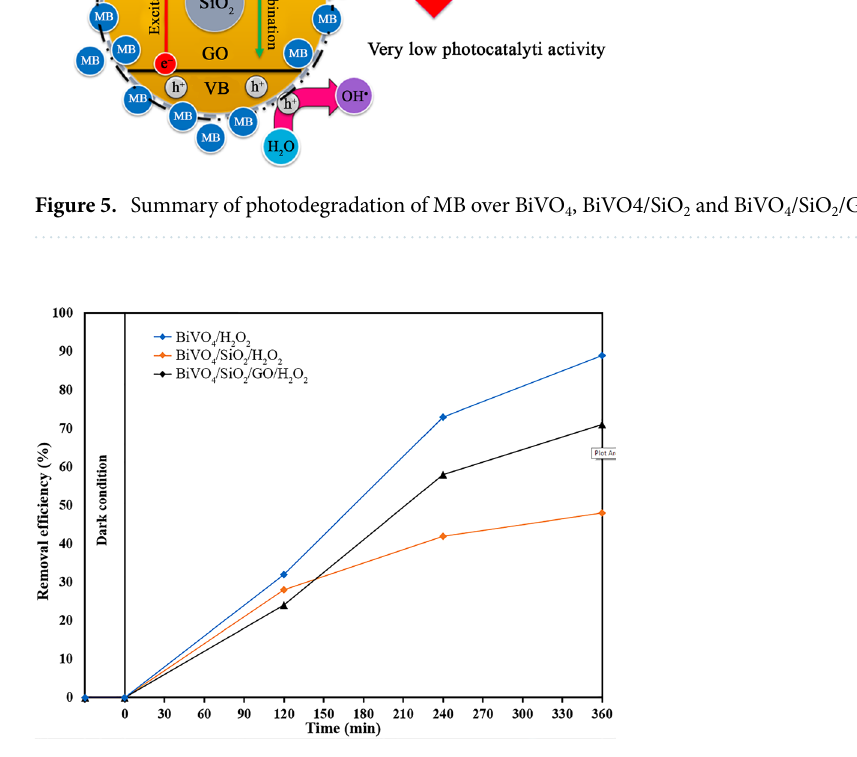
Figure 6. Photodegradation of phenol over BiVO 4 , BiVO 4 /SiO 2 and BiVO 4 /SiO 2 /GO with the presence of H 2 O 2